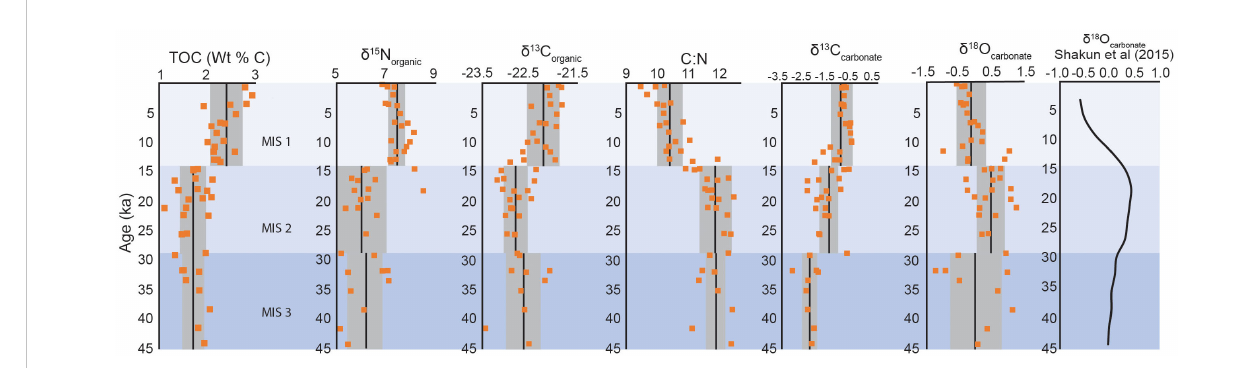
FIGURE 9 Isotopic data of all planktonic foraminifera measured in this study plotted versus regressed radiocarbon ages. Varying hues of blue divide the Marine Isotope Stages 1 – 3 (MIS 1 – 3). Averages (black centerlines) and ±1 standard deviation (gray rectangles) are presented for each isotopic stage. Note that the ~1 ‰ negative shift in d 18 O carbonate corresponds to globally calibrated records of temperature-corrected planktonic isotope curves generated by others (e.g., Shakun et al.,